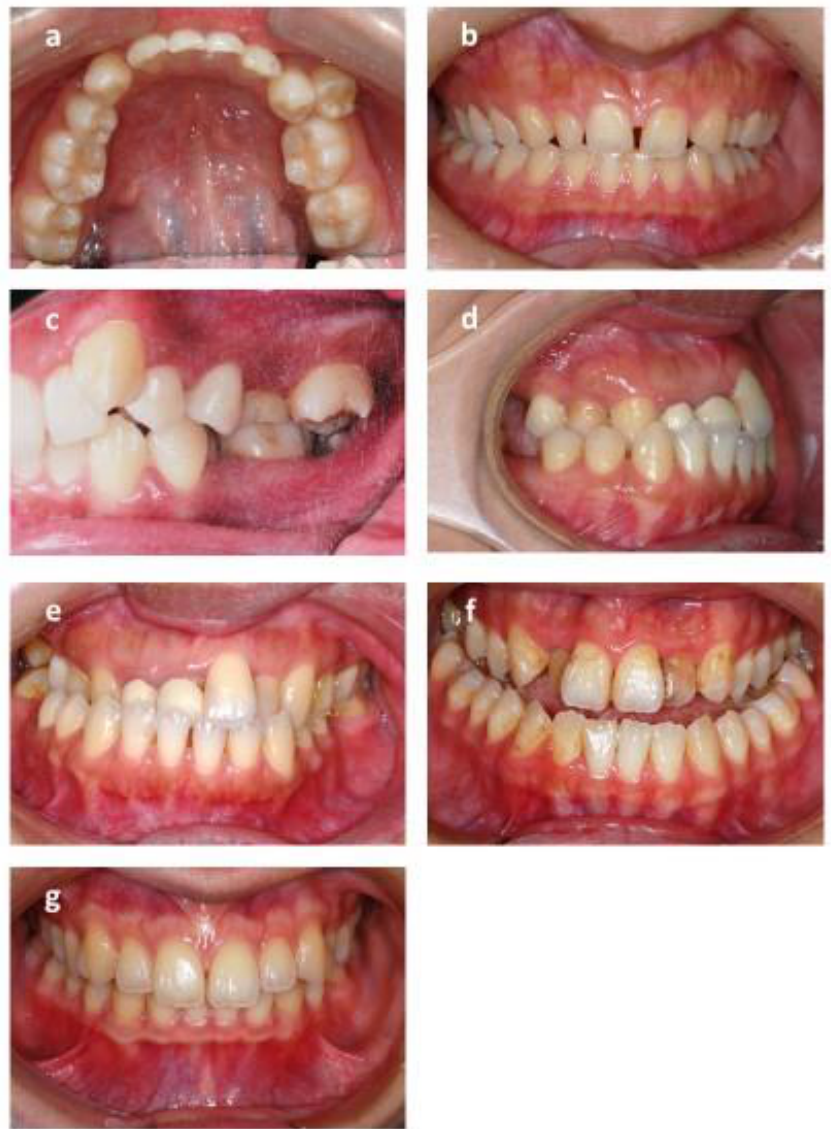
Figure 4. Dental component scale of index of complexity outcome and need (ICON). ( a ) Crowding: crowding occurs when there is a discrepancy between the space required by teeth and the space available in the jawbone. The irregularity index is used for measurement. ( b ) Spacing: the opposite of crowding, the space available is larger than space required. ( c ) Posterior buccal crossbite: buccal cusp of the mandibular dentition occludes lingually to the lingual cusp of the maxillary dentition. ( d ) Posterior lingual crossbite: buccal cusp of the mandibular dentition occludes buccally to the buccal cusp of the maxillary dentition. ( e ) Anterior crossbite: maxillary incisors occlude lingually to mandibular incisors. ( f ) Open bite: there is no vertical overlap between the maxillary and mandibular incisors. ( g ) Overbite: the vertical overlap of the incisors.